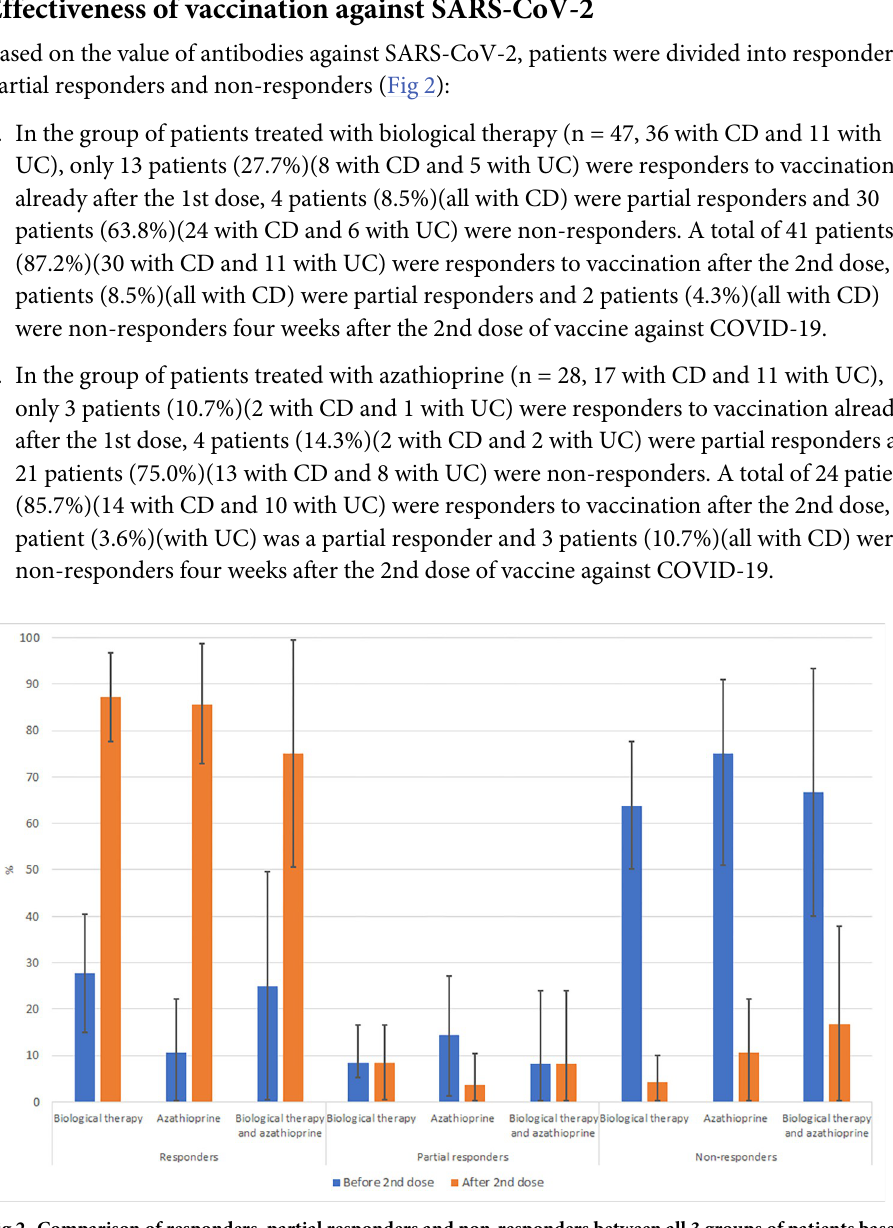
Fig 2. Comparison of responders, partial responders and non-responders between all 3 groups of patients based on the value of antibodies against SARS-CoV-2.